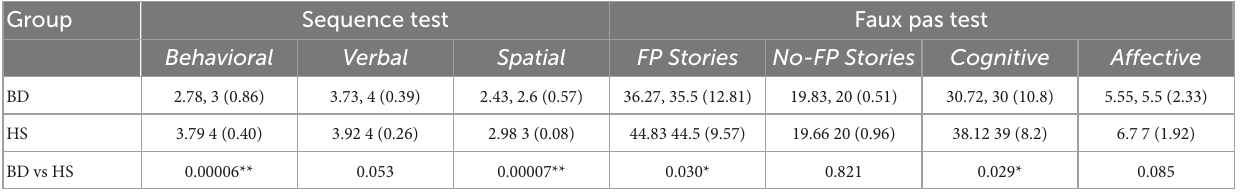
TABLE 2 Descriptive statistics and results of statistical analysis between BD and HS in the Sequence and Faux Pas test results.